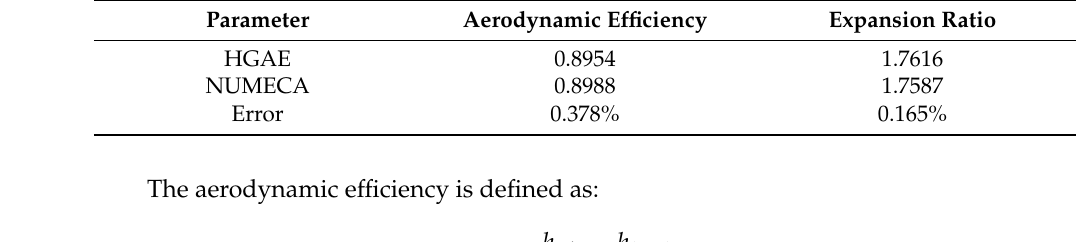
Table 3. Comparison of CFD